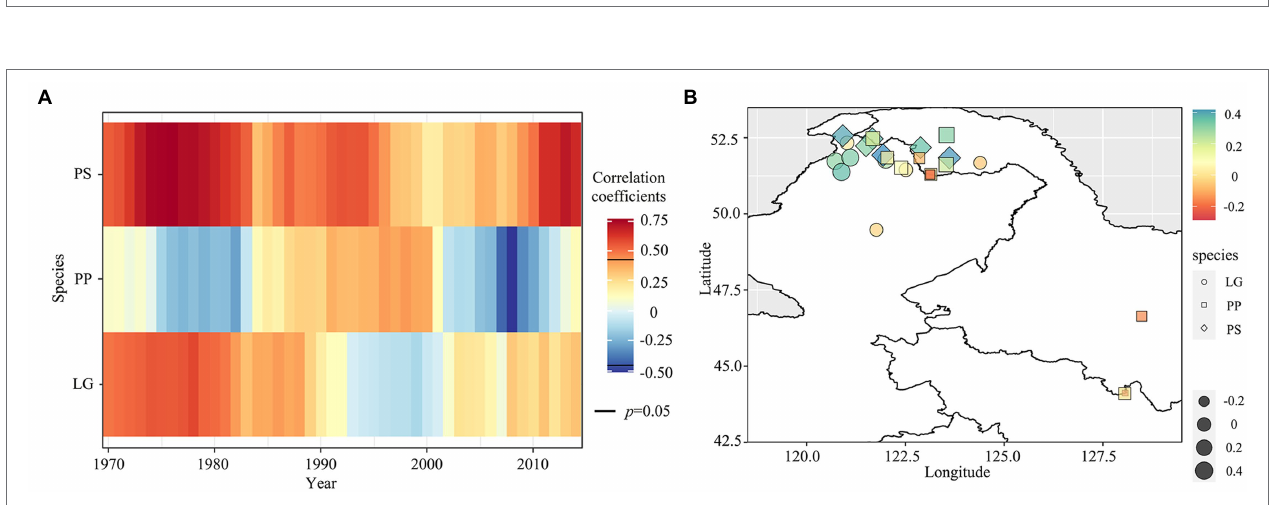
FIGURE 5 | The 21-year moving correlation analysis between the ring-width index of three species and minimum PDSI from June to August during the period 1970–2014 (A) ; the person correlation between the ring-width index and minimum PDSI from June to August in different sites (B)